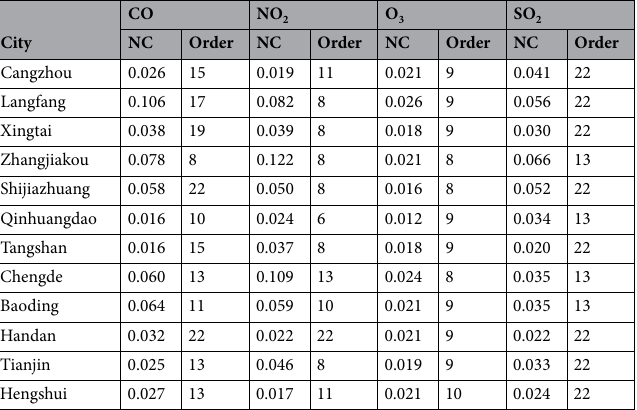
Table 2. NC results of the pollutants from peripheral cities to PM 2.5 concentrations in Beijing.